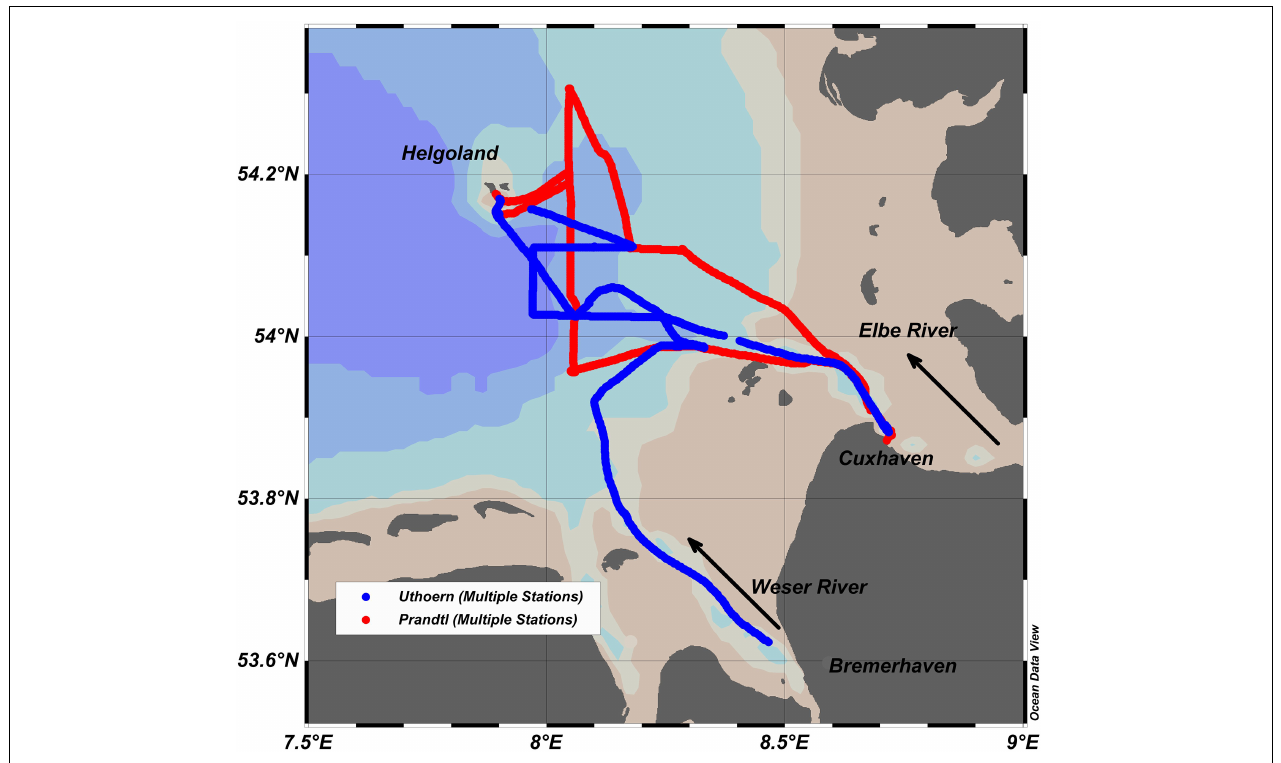
FIGURE 1 | Cruise track of RVs Uthörn in blue and Ludwig Prandtl in red on 25 and 26 June